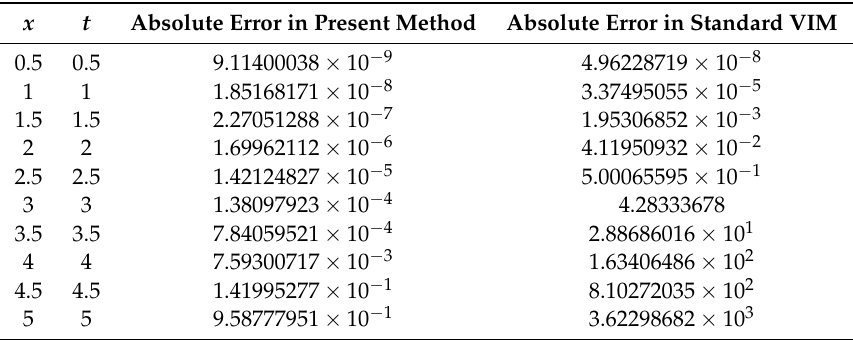
Table 1. Comparison of absolute errors for 16th-order approximation by present method with h = 1.52 and standard variational iteration method (VIM), when α = 0.5 in Example 1.